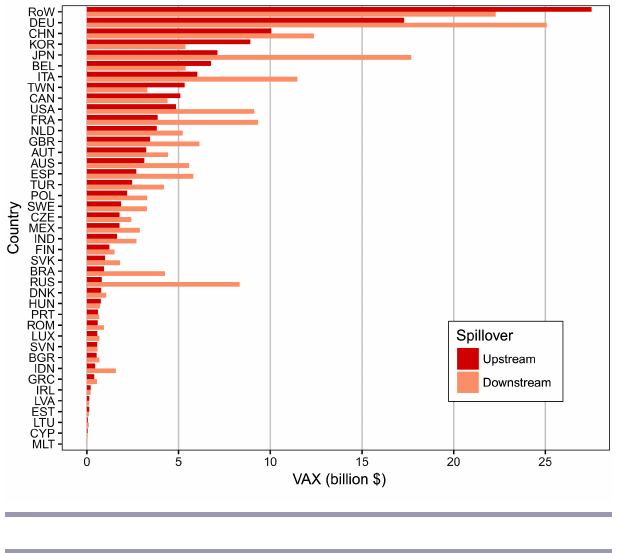
Fig. 4 . Flows of embedded greenhouse gas (GHG) emissions worldwide. Country codes are specified in Table 1.